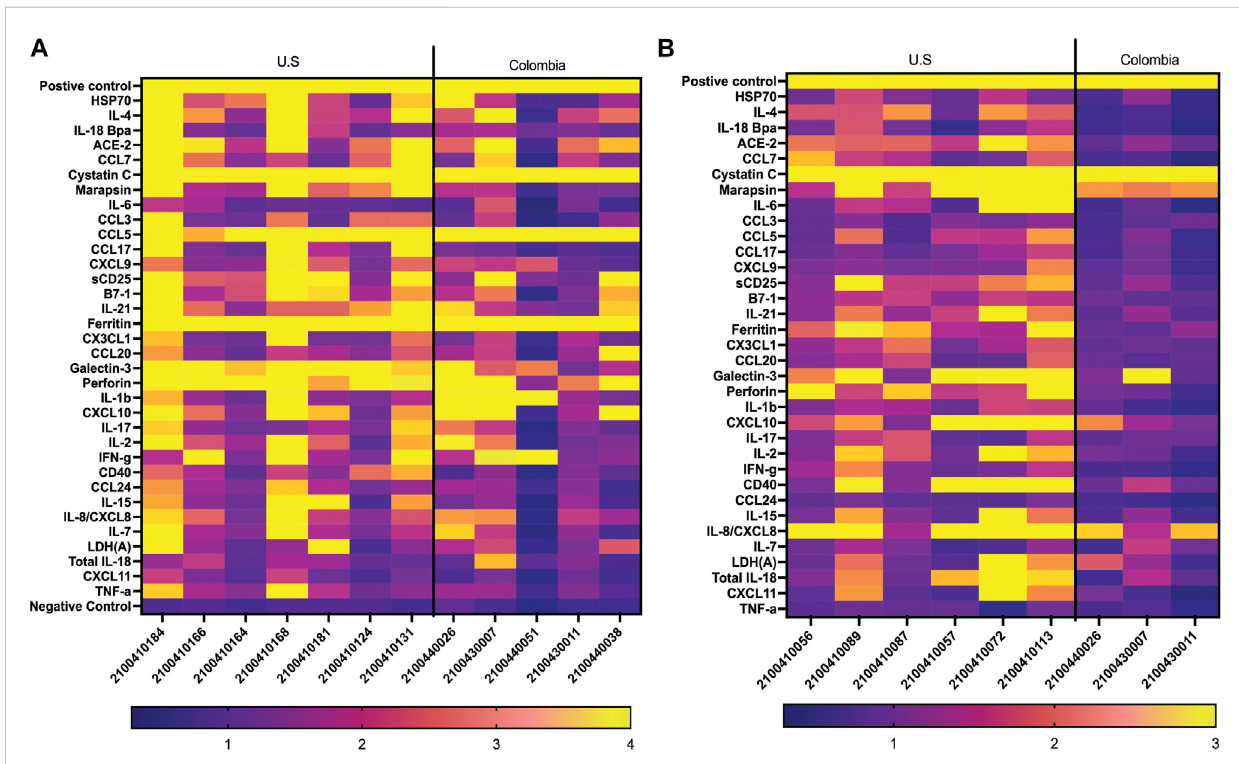
FIGURE 8 Comparison of USA vs. Colombia MIS-C patient samples by GCFP microarray. (A) Heat map of A2 serum samples comparing USA to Colombia samples. The USA patient population has a more robust signature. (B) Heat of A2 saliva samples comparing USA to Colombia samples, USA has a more robust